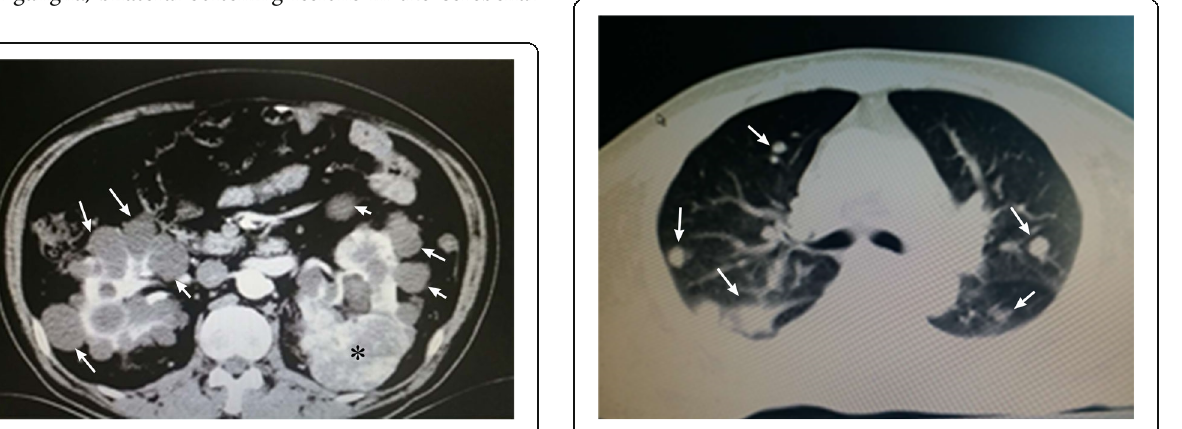
Fig. 2 CT image of bilateral kidney tumours and polycystic kidneys. CT images were taken from both kidneys at the lumbar level from the subject of case 1. Arrows indicate multiple kidney cysts. Asterisks indicate kidney tumours